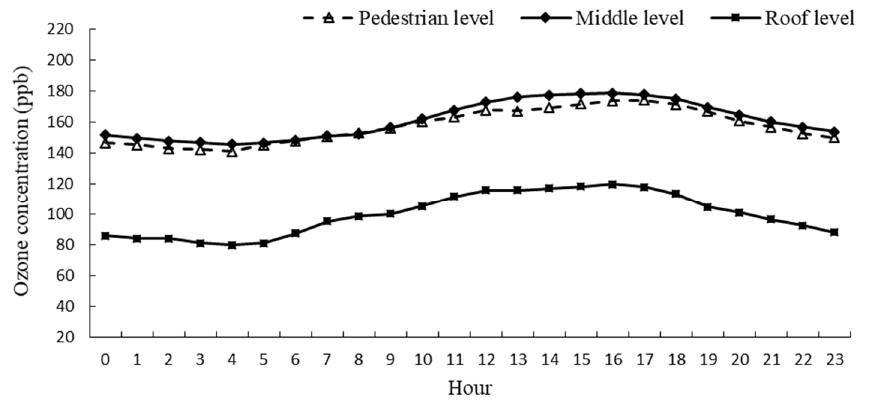
Figure 3. Hourly variations of O 3 concentration in the street canyon at three levels: pedestrian level, middle level, and roof level.